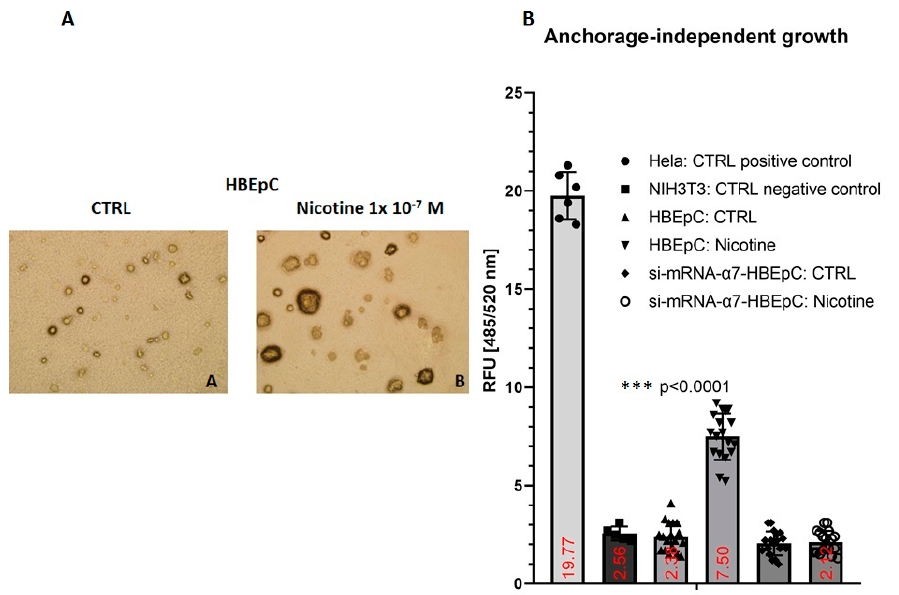
Figure 12. Anchorage-independent growth induced by nicotine in HBEpC. HeLa cells are positive control and NIH3T3 the negative. ( A ): Representative picture of HBEpC cloned on soft agar. ( B ): Cloned cells. Statistical significance is analyzed with one-way ANOVA with multiple-comparison and post hoc test with Bonferroni correction. Experiments are performed at least two times in triplicate.